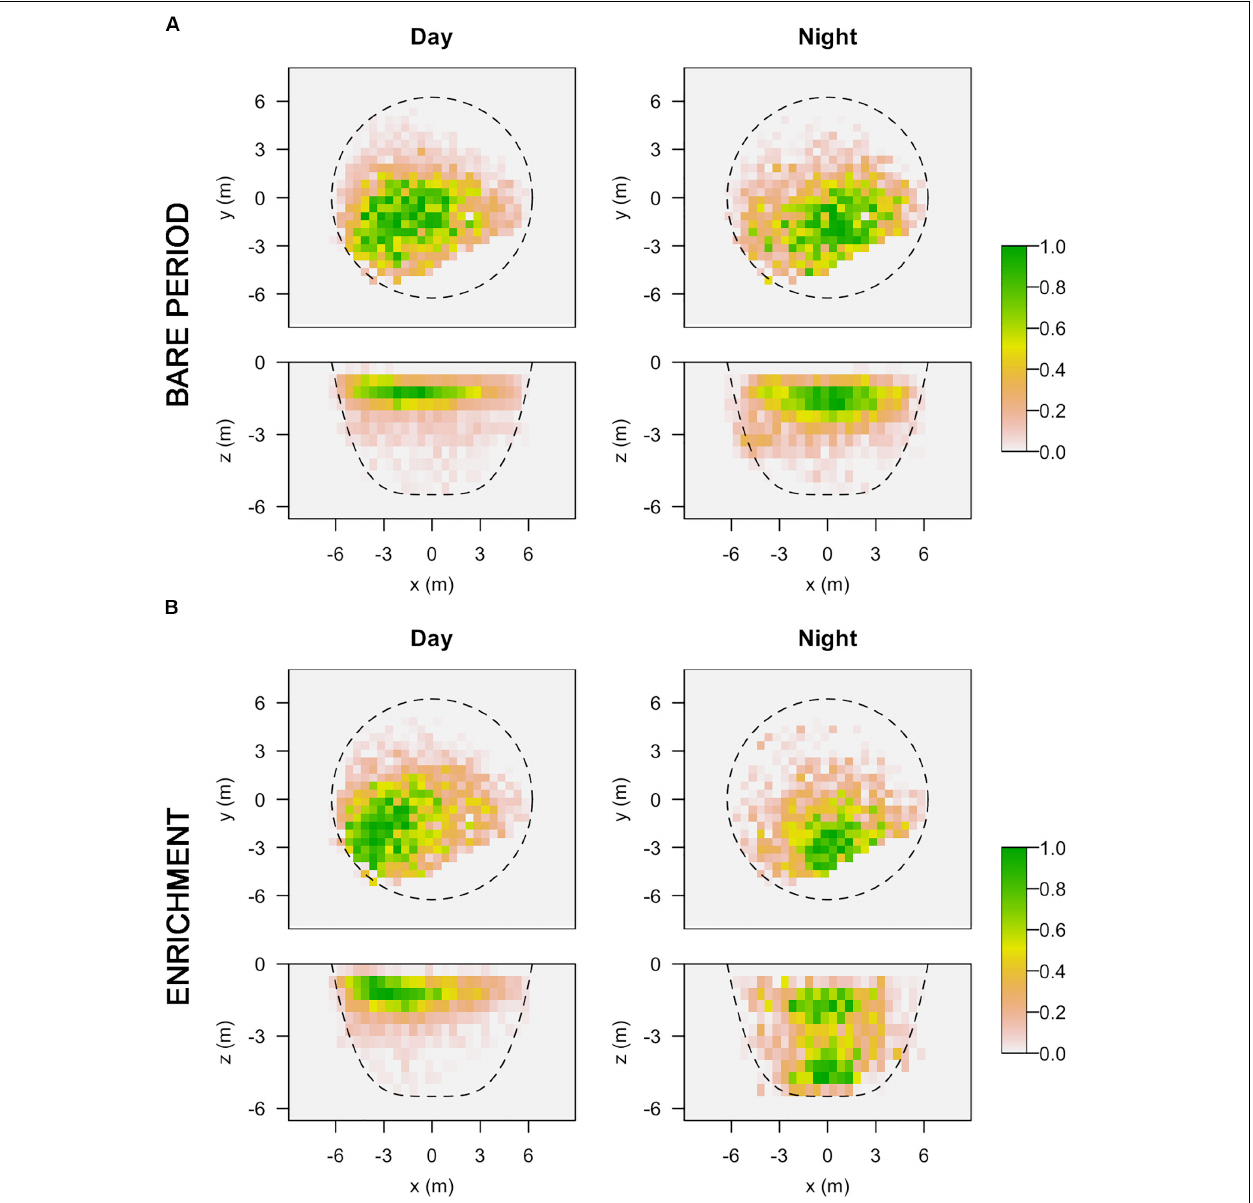
FIGURE 3 | Horizontal and vertical representation of 3D kernel utilization distributions (KUDs) for all the tagged fish at day (left) and night (right) time, during the bare (A) and enrichment period (B) . Color gradient represents percentage of space utilization for all tagged